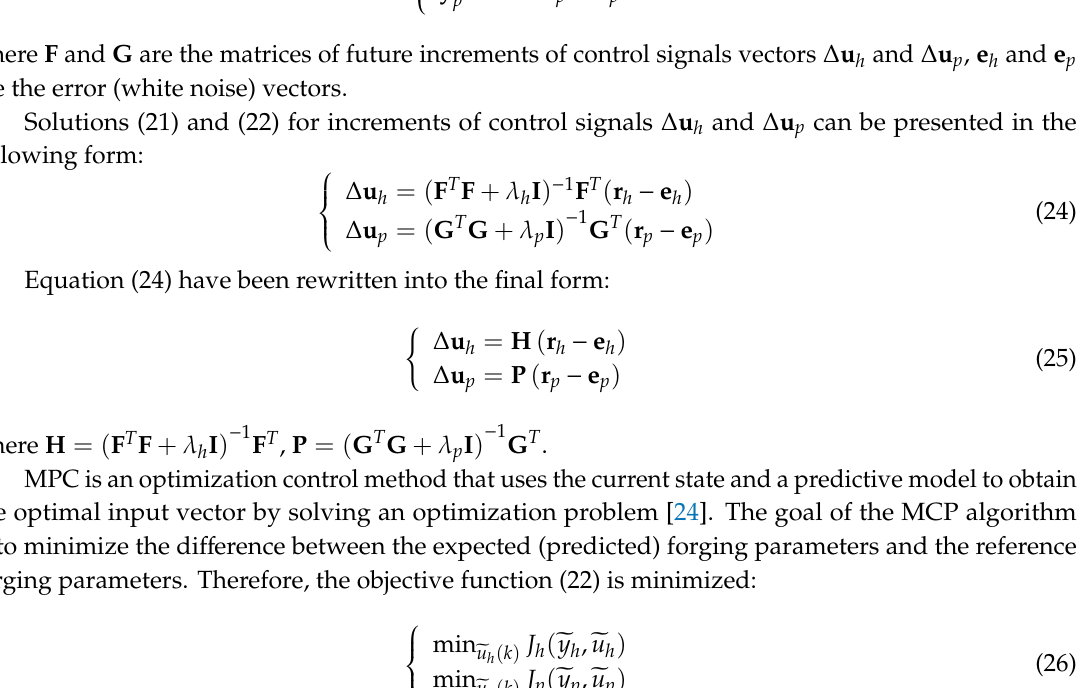
trajectories: 𝑦(cid:3556) h = h ( t ) and 𝑦(cid:3556) p = p ( t ) for optimal input signals: 𝑢(cid:3556) h and 𝑢(cid:3556) p are shown in Figure 16.